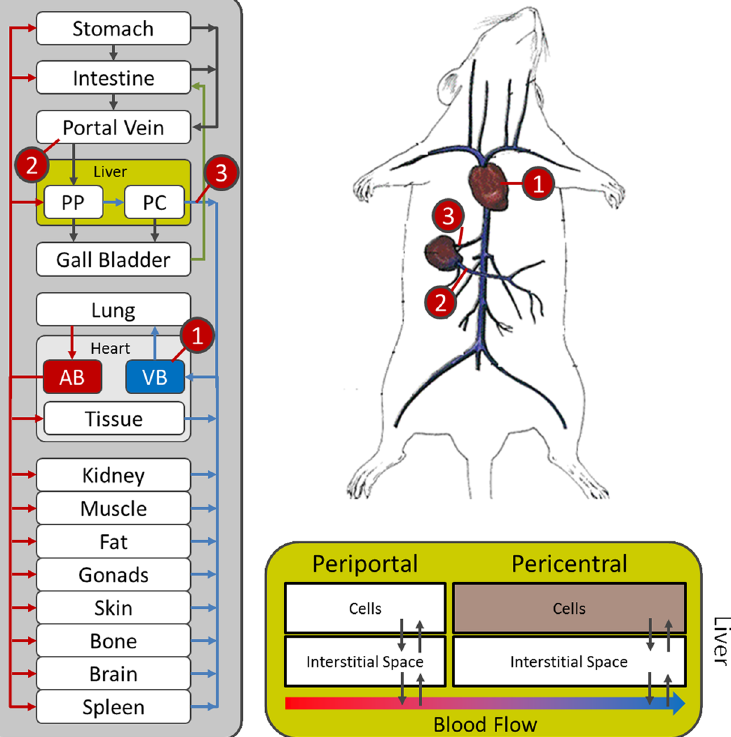
Figure 2. PBPK modelling in mice. Plasma concentration profiles from three different sampling sites where used in this study: the right heart chamber (1) and the portal vein (2) (both contributing to the liver inflow) and the hepatic vein (3) (representing the liver outflow). Due to the detailed structure of PBPK-models (left), it was possible to include all three sampling sites into the model at the same time (upper right). The volume fractions of the periportal and the pericentral zone of the liver lobule (lower right) were set according to the previously determined fractions of expression (Table 1).